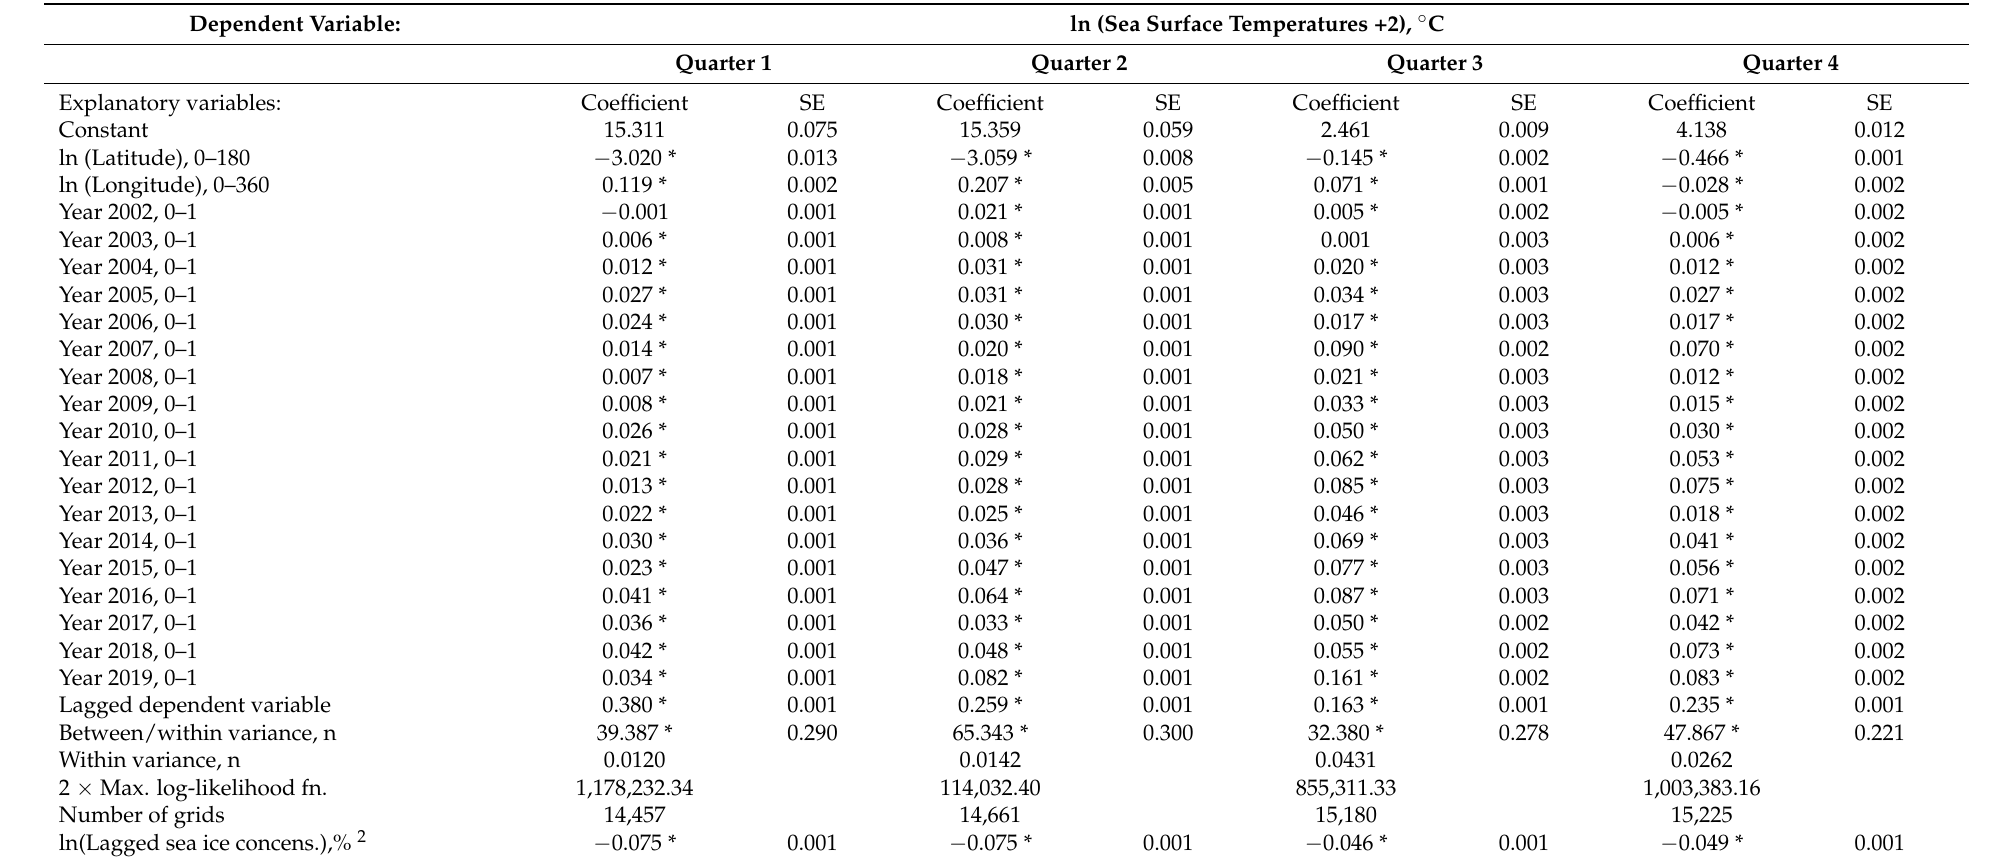
Table 3. Maximum likelihood estimates of dynamic random effects models using quarterly data for 2000–2019 for 1 × 1 degree grids on sea surface temperatures in the Northern hemisphere explained by geodesic variables and time indicators for the years 1